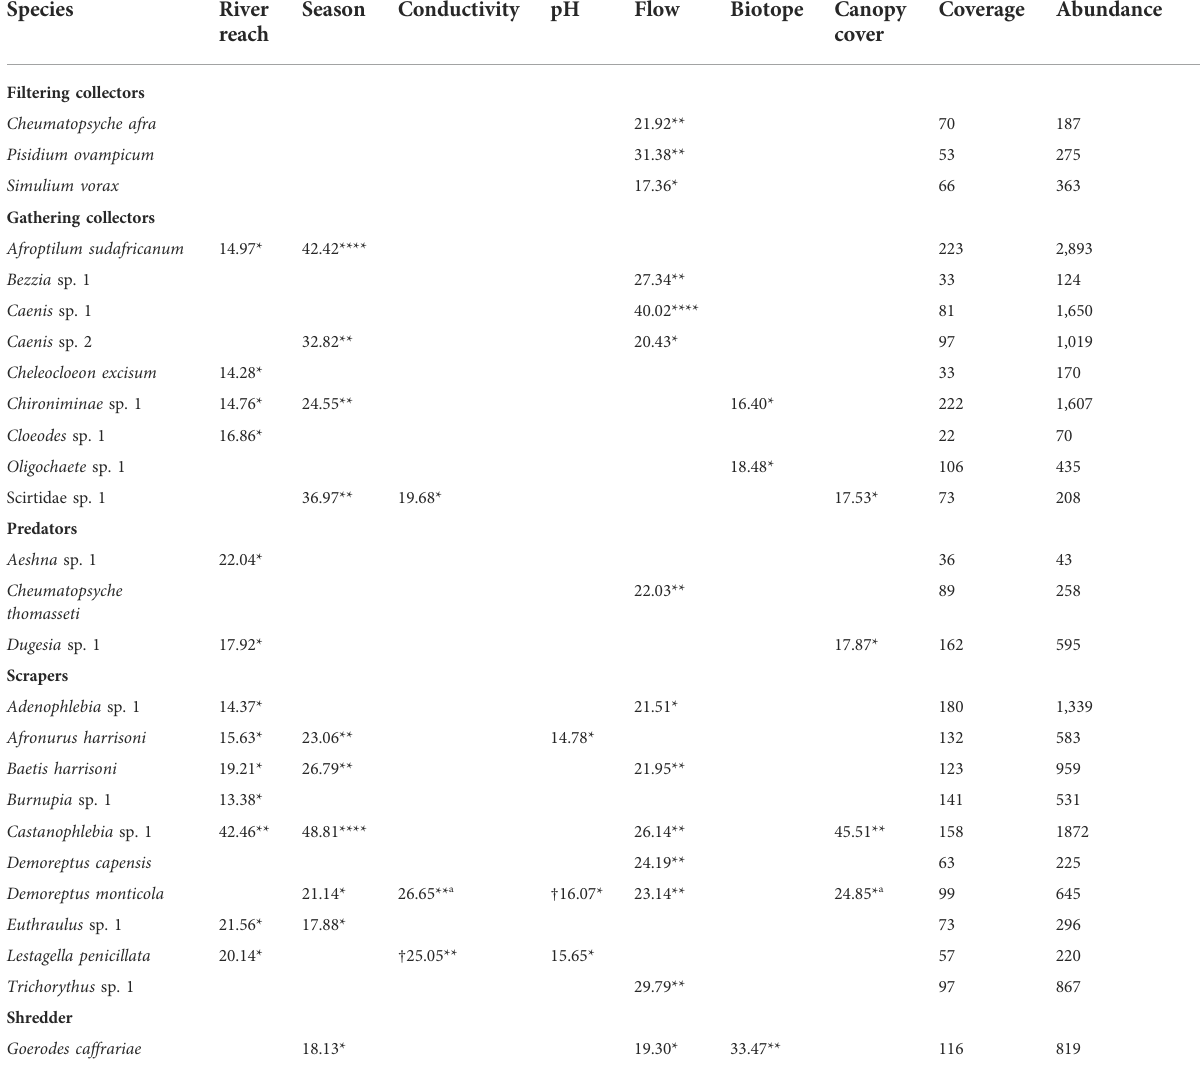
TABLE 3 Univariate results (marginal analysis of variance) for those species that had a signi fi cant relationship with one or more of the predictor variables. Rao ’ s score test statistics are given, and p -value, adjusted for multiple testing, is symbolised using asterisks. Coverage indicates the number of samples (out of 320) each species was present in, while abundance re fl ects the total count of individuals across all samples.